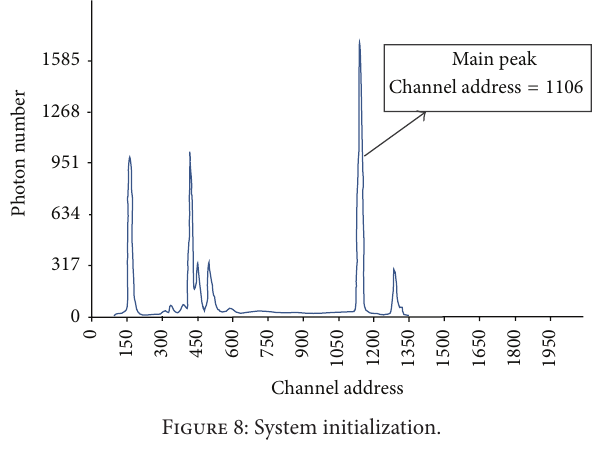
Figure 8: System initialization.